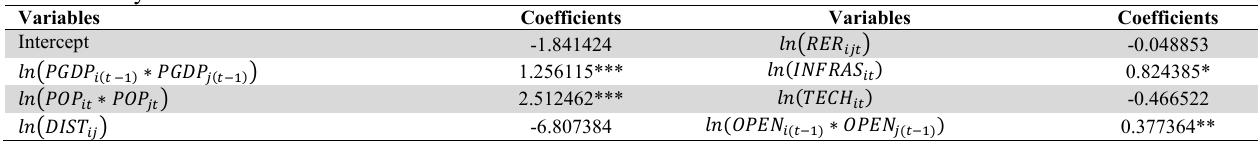
Hausman-Taylor Estimation